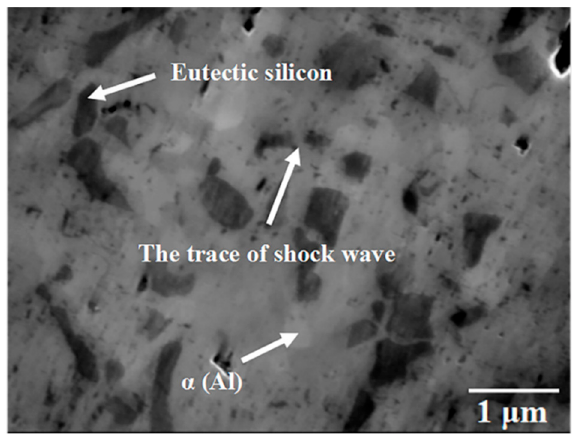
Figure 5. SEM morphology of thermal-affected zone in cross-sectional microstructures of Al–20Si–5Mg alloy after HCPEB treatment with 25 pulses.